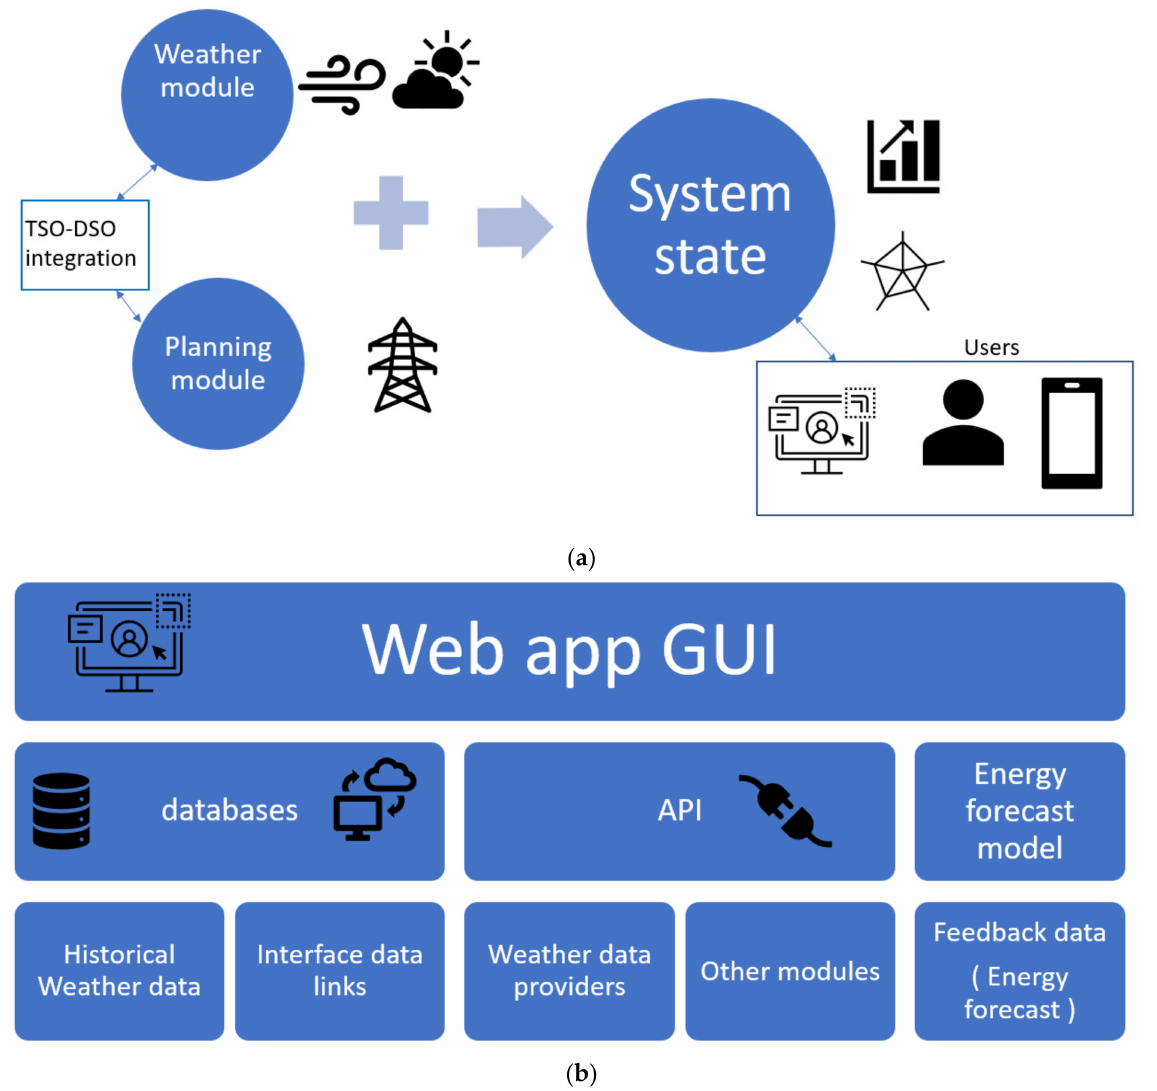
Figure 6. ( a ) Proposed system layout for the F-channel. ( b ) Cloud computing